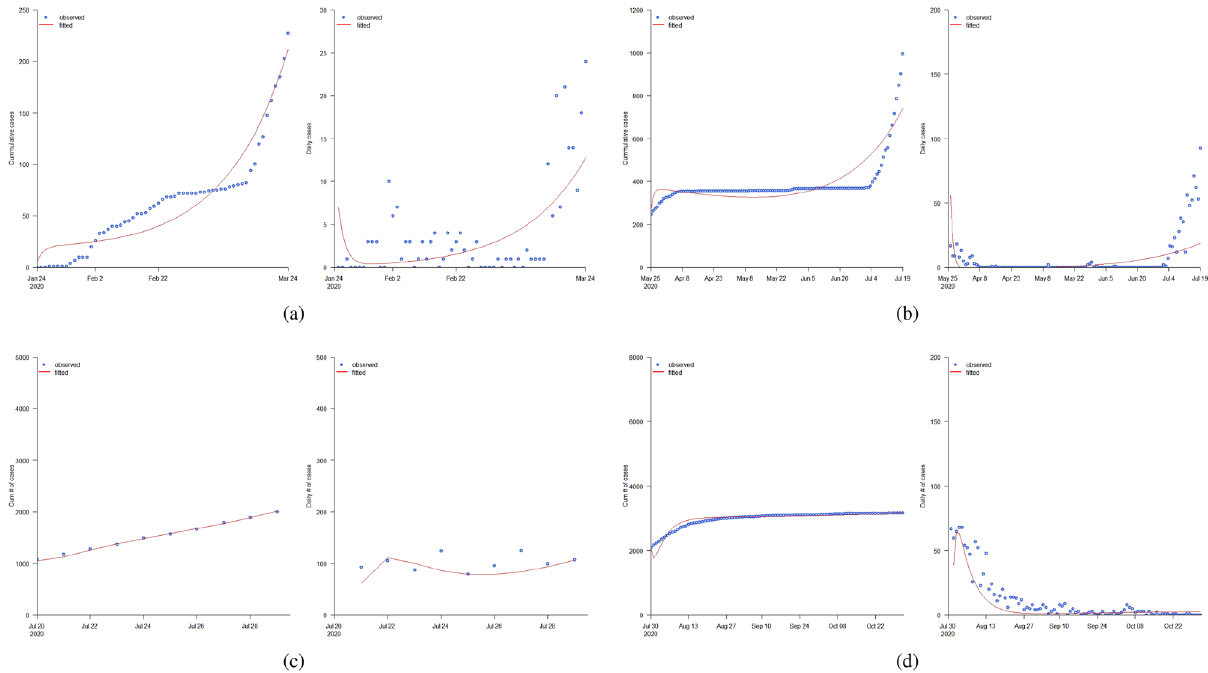
Figure 5. Fitting results: ( a ) Jan. 24 to Mar. 24, ( b ) Mar. 25 to Jul. 19, ( c ) Jul. 20 to Jul. 29, and ( d ) Jul. 30 to Oct. 31.